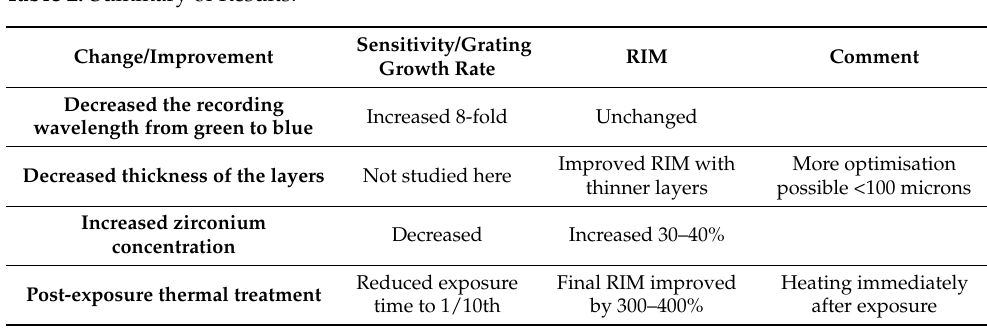
Table 2. Summary of